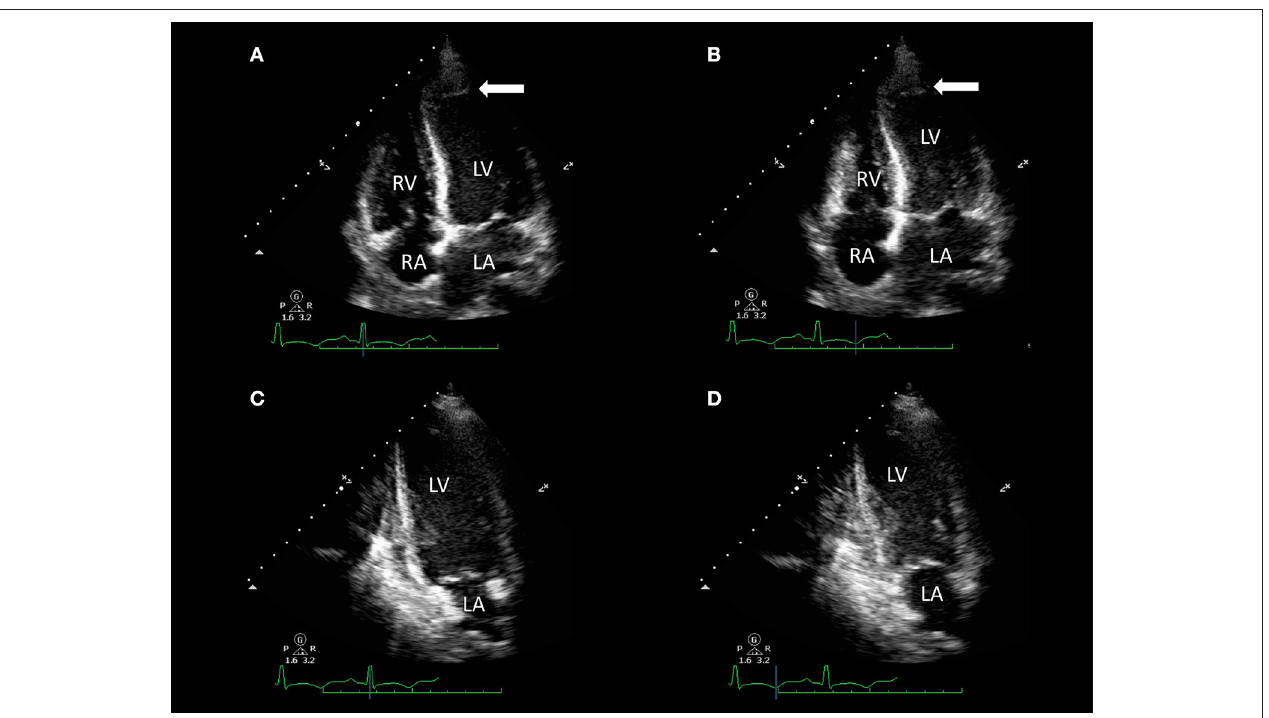
FIGURE 2 | Transthoracic echocardiography of a 32-year-old woman with acute dyspnea 1 day after delivery. Apical four-chamber view [end-diastolic (A) and end-systolic (B) frames] and two-chamber view [end-diastolic (C) and end-systolic (D) frames] show akinesia of apical segments of the left ventricle (LV) and mild-to-moderate LV systolic impairment [LV ejection fraction (LVEF) 45%] with evidence of apical LV thrombus (arrows). Resting right ventricle (RV) function was preserved (fractional area change